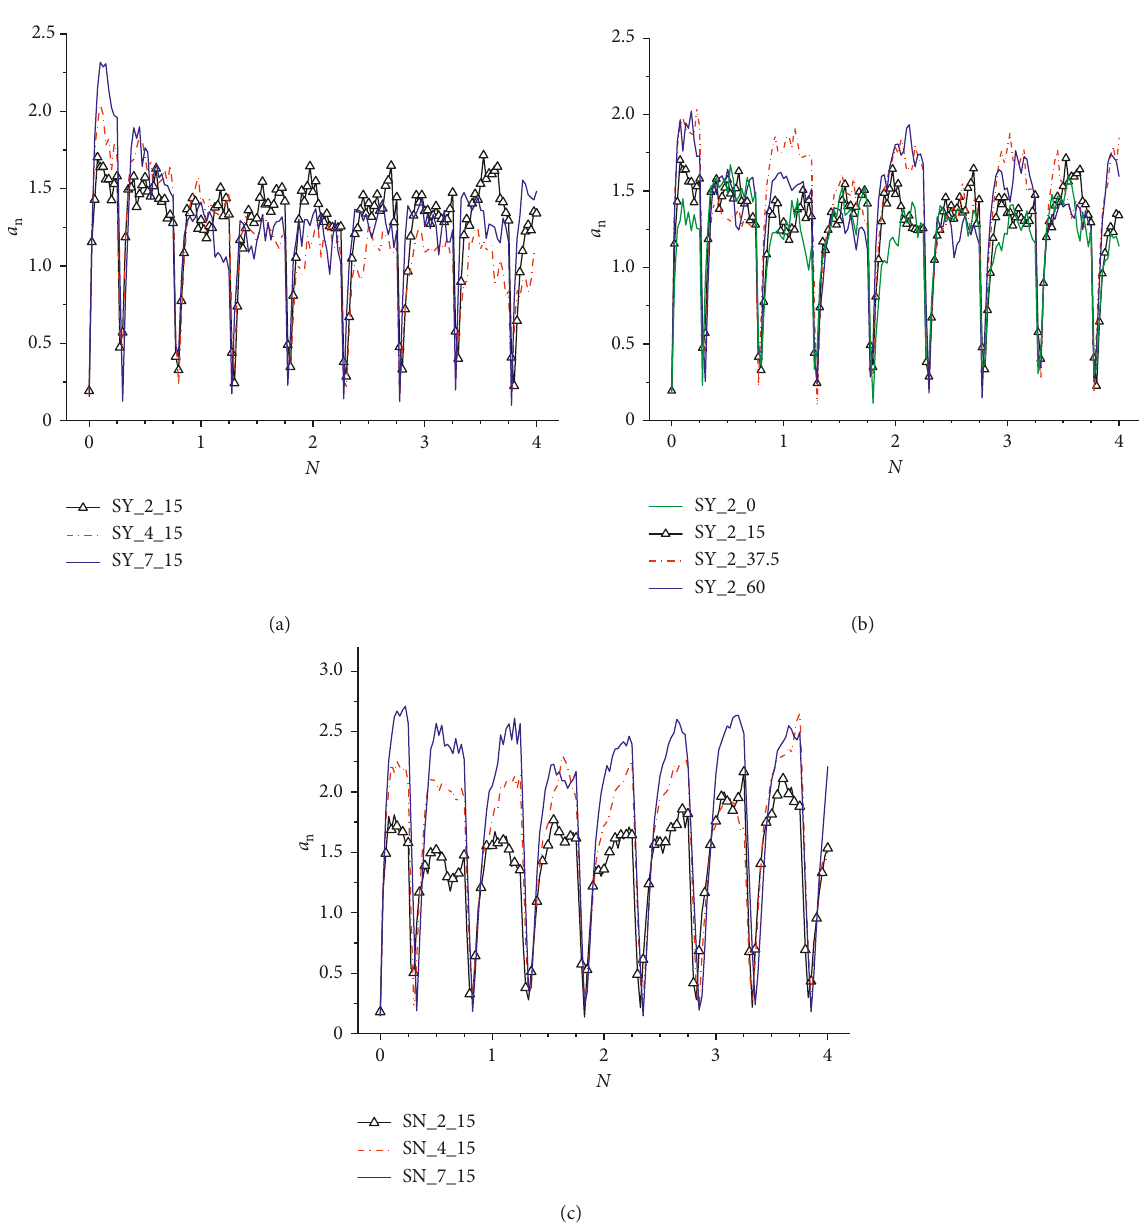
Figure 17: Evolution of a : (a) reference group; (b) composite pattern group; (c) unbreakable n